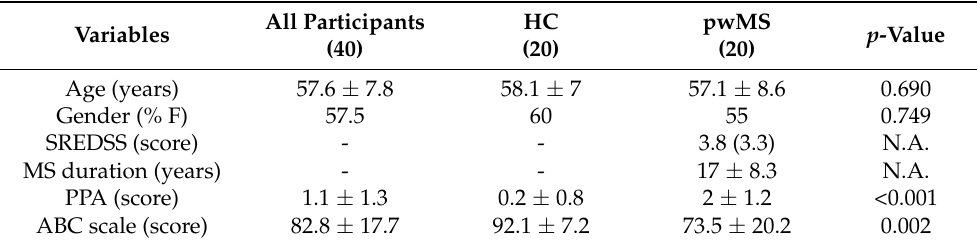
Table 1. Demographic and clinical characteristics of study participants: results are expressed as mean ± SD or median